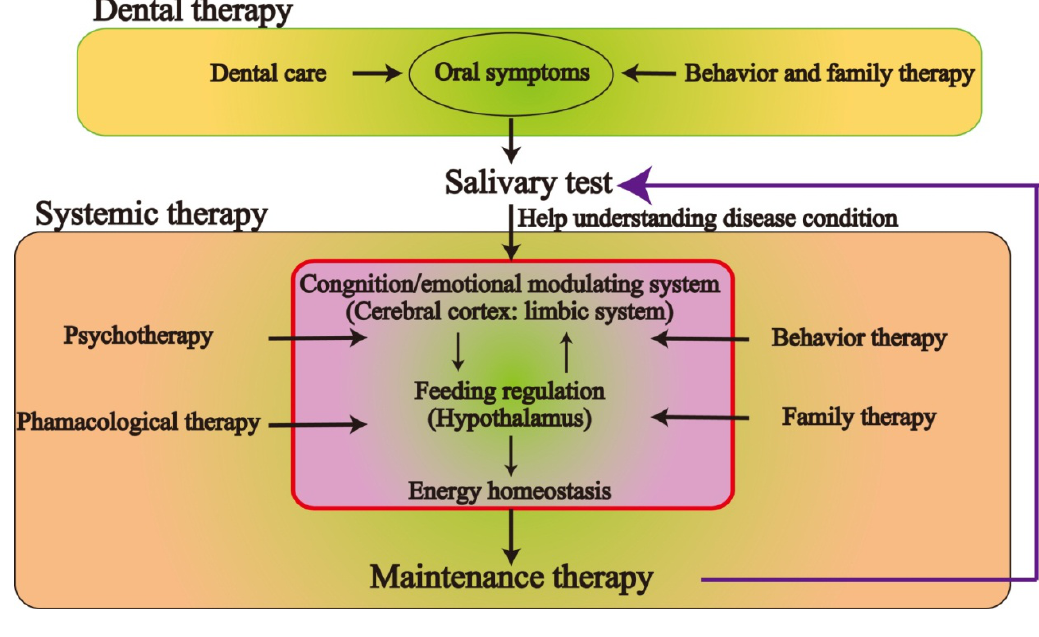
Figure 3. Schematic representation of the recommended treatment strategy for eating disorders. A multi-disciplinary team should manage each treatment stage for patients with eating disorders. Dental therapy teams are essential for initial detection of and pain control in oral manifestations. In addition, professional care provided by a dental practitioner will aid in the maintenance of oral function and hygiene control. However, systemic therapy requires behavioral and pharmacological approaches for control of energy homeostasis and